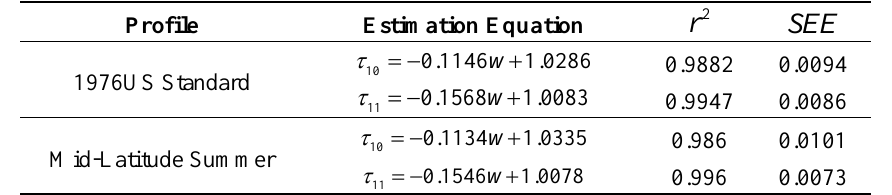
Table 2. Relationship between atmospheric transmittance and water vapor content in the column for the water vapor content range of 0.5–3 g · cm −2